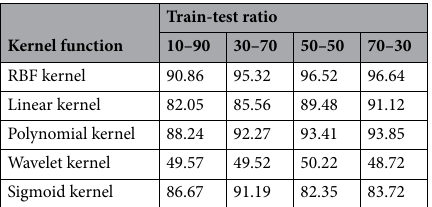
Table 4. Performance measures with different kernel functions obtained on KELM classifier.